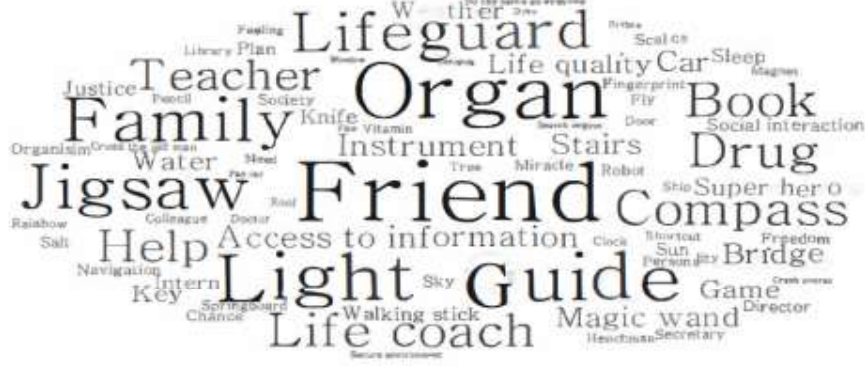
Figure 1. Word cloud of metaphors produced by special education pre-service teachers on the concept of AT